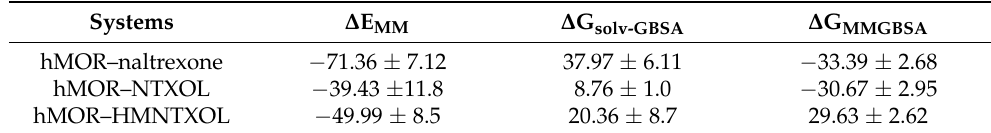
Table 1. Binding free energy components for protein–ligand interactions of hMOR–naltrexone, hMOR–NTXOL, and hMOR–HMNTXOL systems calculated using the MMGBSA approach